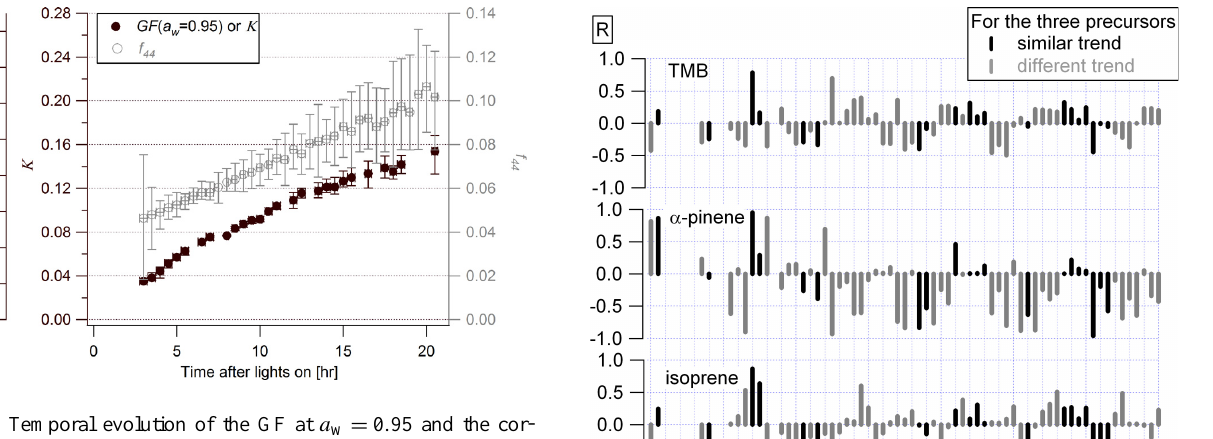
Fig. 3. Temporal evolution of the GF at a w = 0 . 95 and the cor- responding κ org value (closed symbol) and f 44 (open symbol) for SOA formed from 150 ppb TMB and 75ppb NO 2 (Experiment 1 from Table 1). Each data point represents a 30-minute average.